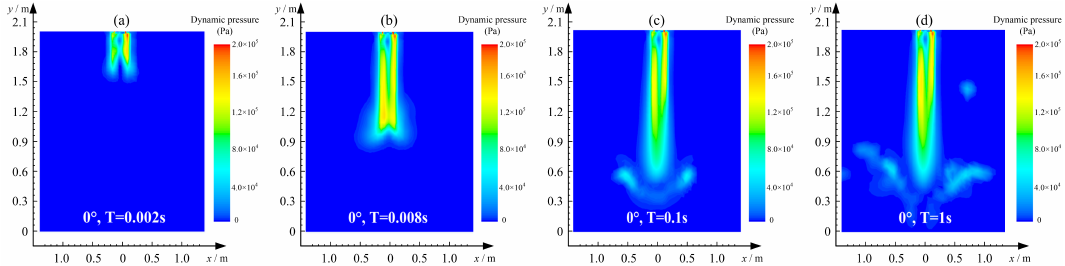
Figure 4. Dynamic pressure profiles in the blowing process with multi-nozzle oxygen lance (NTA = 0 ◦ ). ( a ) Flow time = 0.002 s, ( b ) flow time = 0.008 s, ( c ) flow time = 0.1 s, ( d ) flow time = 1